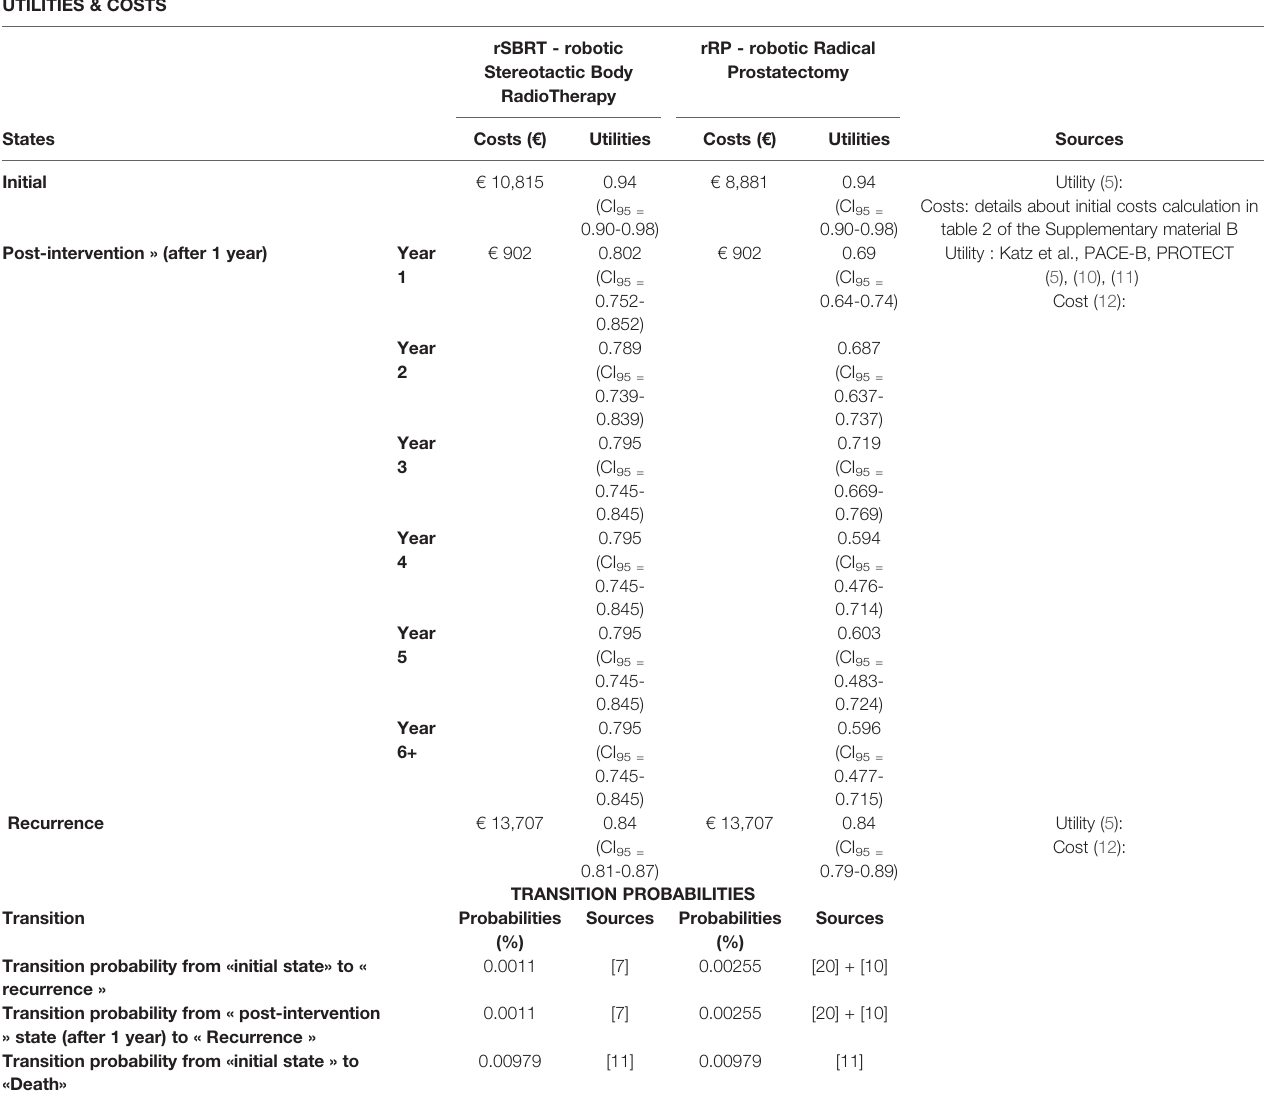
TABLE 1 | Summary of utilities, costs and transition probabilities of the different states calculated and collated for rRP and rSBRT. UTILITIES & COSTS